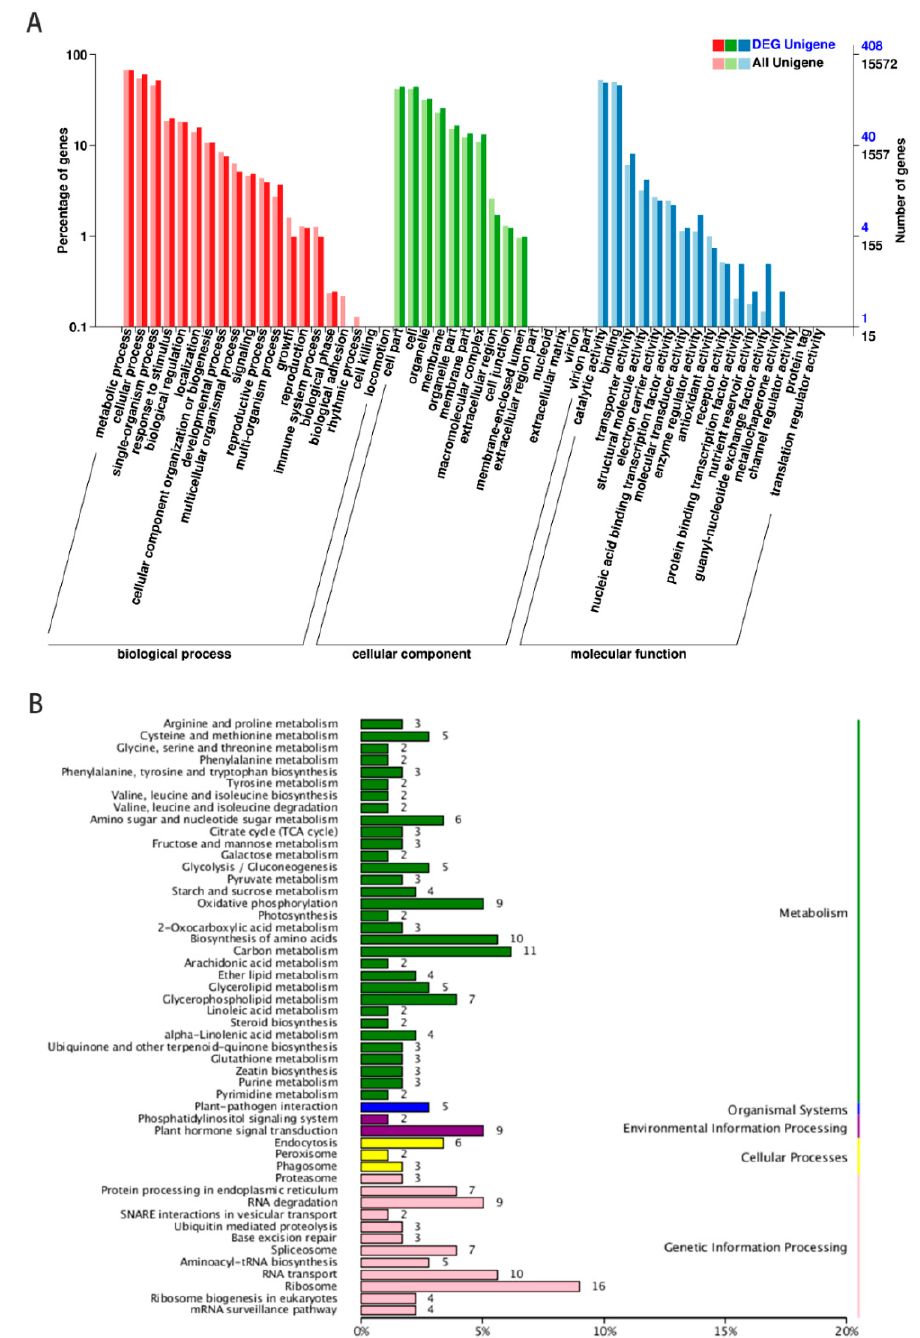
Figure 3. GO terms and KEGG pathway enrichment in tomato RKNT and Sneb821T. ( A ) Gene categories disctribution of lncRNAs under molecular functions (481 genes), cellular components (790 genes), and biological processes (1115 genes). ( B ) KEGG pathways enrichment of neighboring genes of lncRNAs in cellular processes (11 genes), environmental information processing (11 genes), genetic information processing (73 genes), metabolism (120 genes) and organismal systems (5 genes).